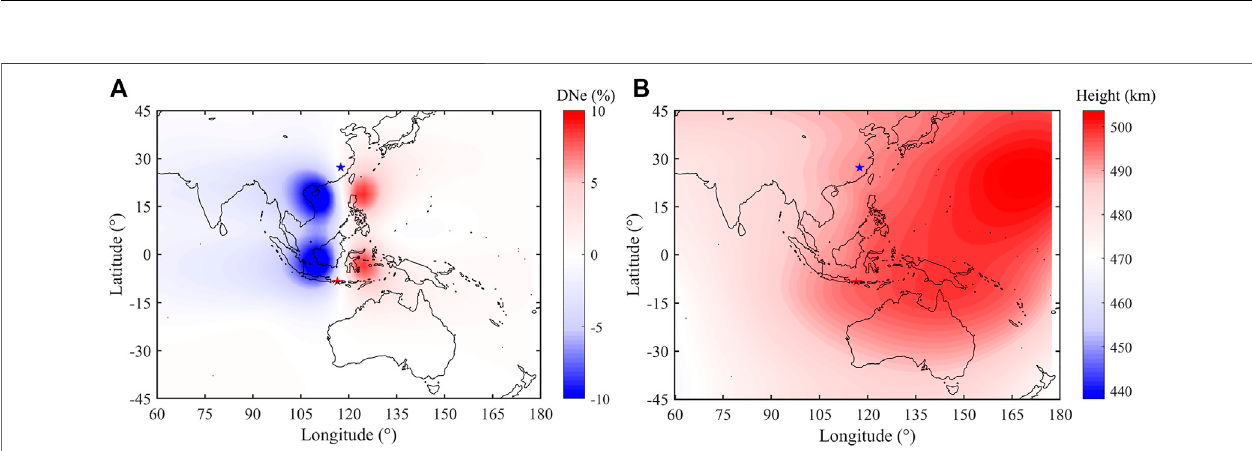
FIGURE14 | Simulation result at 14:00 (LT) on 31 July2018. (A) Distribution of Ne relative change with and withoutpenetrating the electric fi eld, and (B) altitudeof Ne in (A) . Red and blue stars represent epicenter and its conjugate point, respectively.